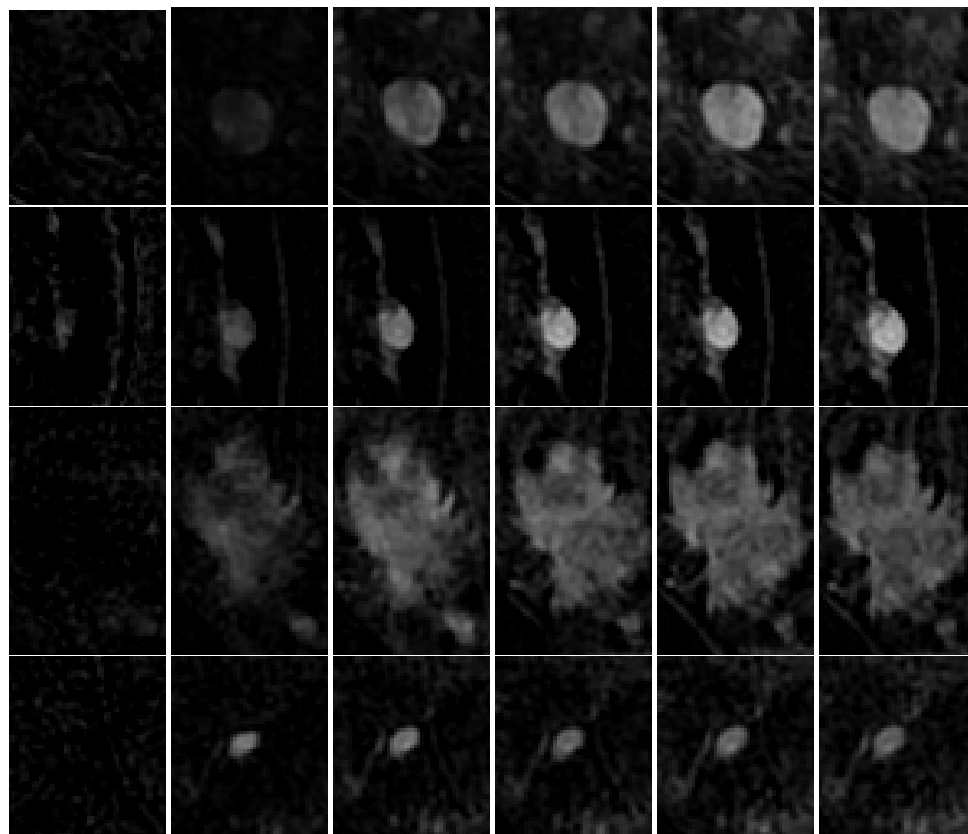
Figure 1. Examples of DCE-MRI phases related to four breast cancer patients (one per row): malignant lesions are shown on rows 1 and 3, while benign lesions are shown on rows 2 and 4. Among phases, for segmentation purposes the clinician selected the strongest one. In particular, for these lesions, the 4th, 3rd, 4th, and 3rd phase was chosen,